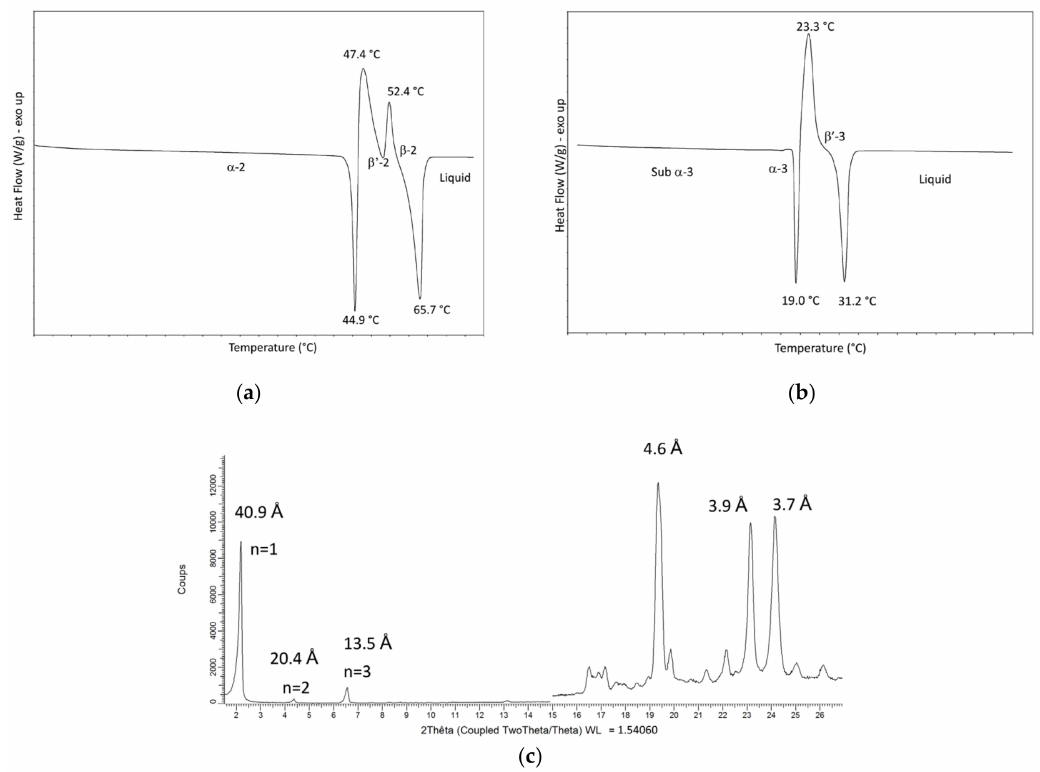
Figure 2. ( a ) Di ff erential scanning calorimetry (DSC) melting profile of PPP in direct mode; ( b ) DSC melting profile of OPP in direct mode and ( c ) powder X-ray pattern of PPP in β -2 (n = order of